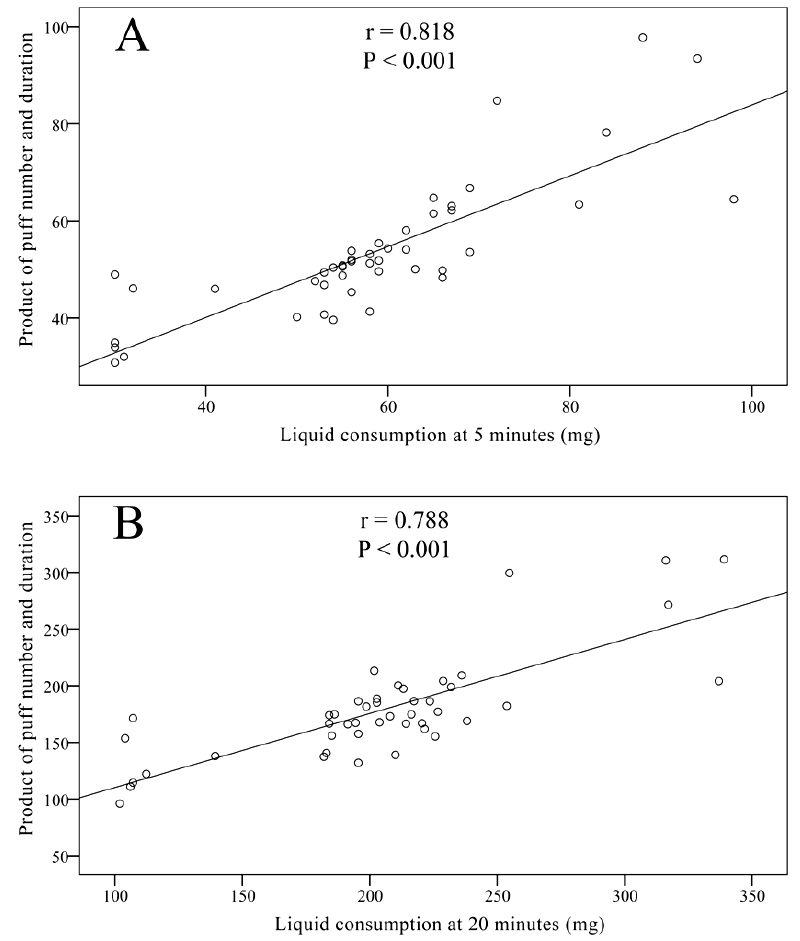
Figure 2. Correlation between electronic cigarette liquid consumption and product of puff number and duration, at ( A ) 5 and ( B ) 20 min of